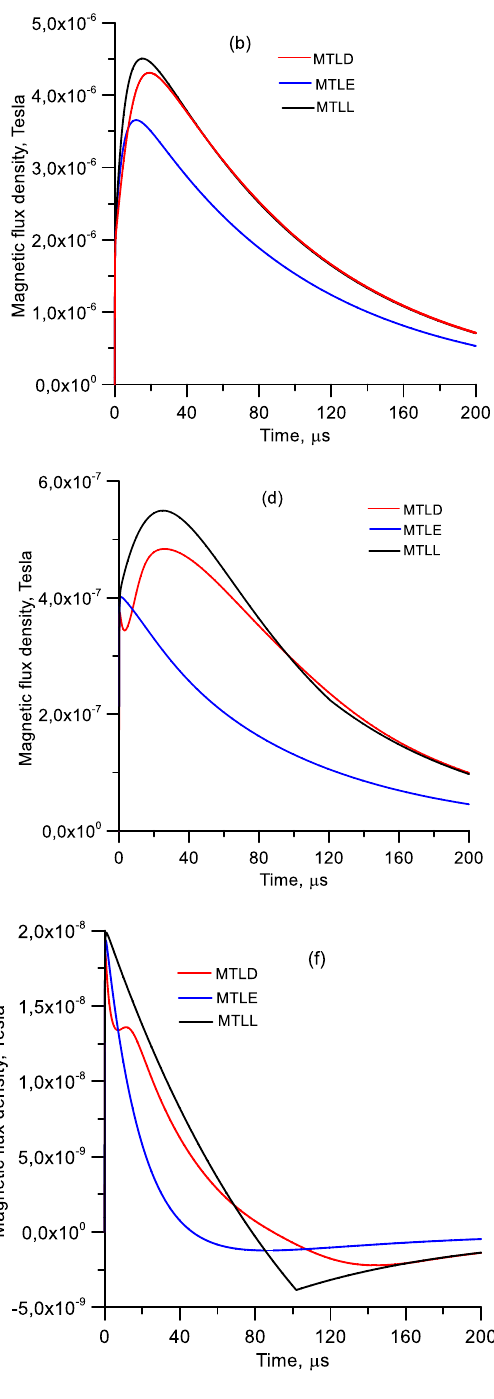
Figure 11. Electric field of first return strokes at different distances as predicted by the MTLD (with dispersion and decreasing velocity profile with 50 m, ( b ) 1 km, ( c ) 2 km, ( d ) 5 km, ( e ) 10 km and ( f ) 100 km. In the MTLE model, in the MTLL model, H = 10 km are used as model parameters. In the MTLE and MTLL models, the return stroke speed remains constant at 1.0 × 10 8 m/s.